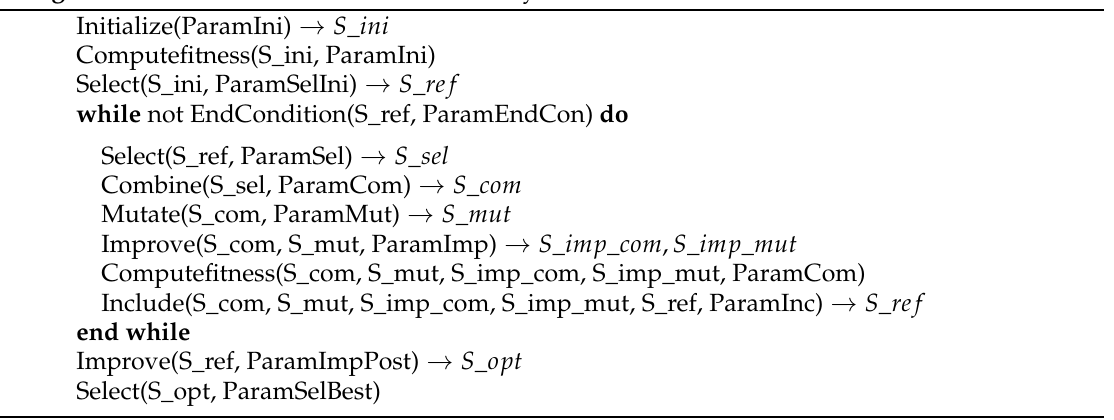
Algorithm 1: Parameterized schema for the hybrid metaheuristic